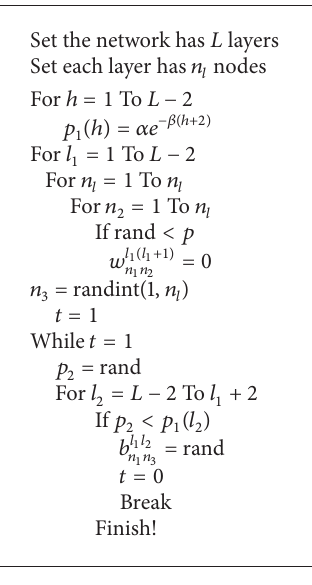
Algorithm 1: Constructive procedure of the small-world neural